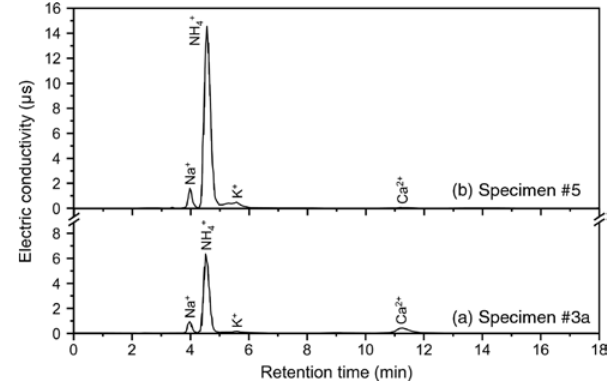
Figure 3: IC spectra of specimens 3a and 5.